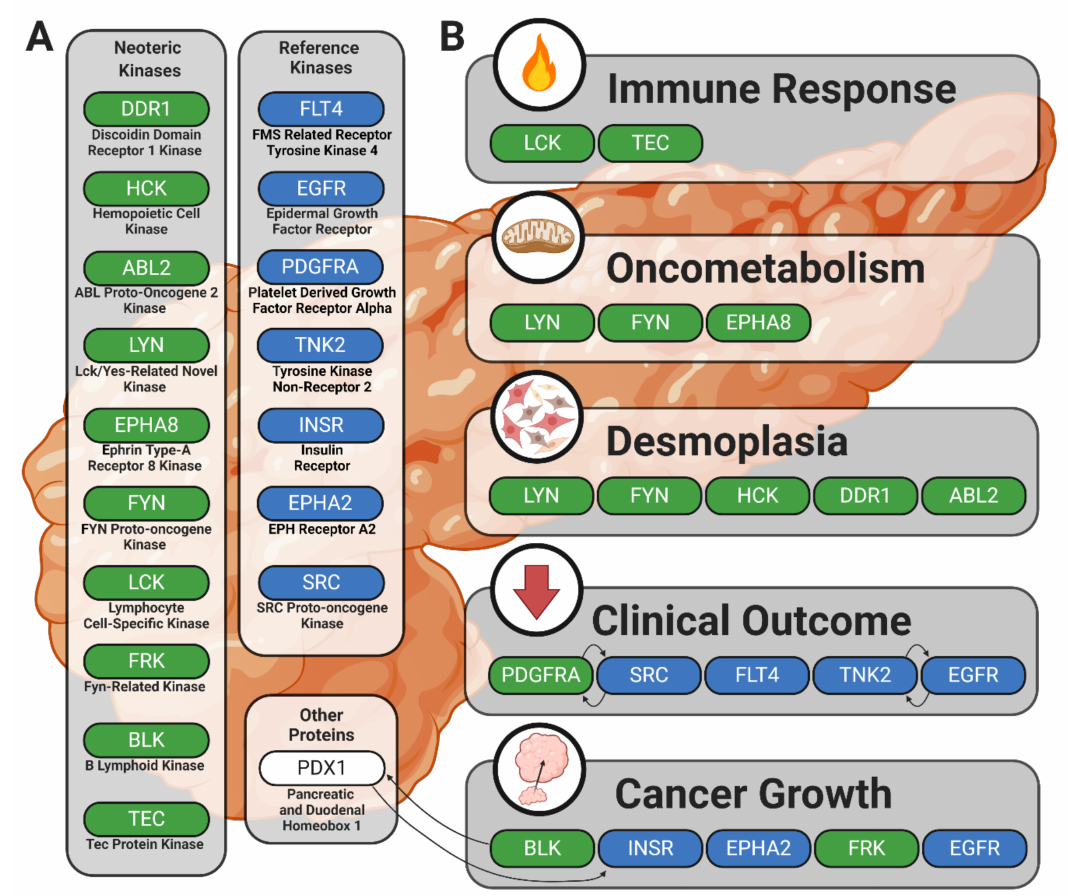
Figure 5. Summary figure illustrating kinases showing increased enzymatic phosphorylation activity in PDAC and their potential roles in the disease process. Solid black arrows indicate relationships between kinases or other proteins. ( A ) The neoteric kinase group includes candidate kinases potentially contributing to PDAC pathology in new or previously understudied ways; the reference kinase group includes kinases with well-established roles in human cancer pathophysiology. ( B ) Kinases are clustered by linkage to the processes that might underlie their involvement in PDAC.